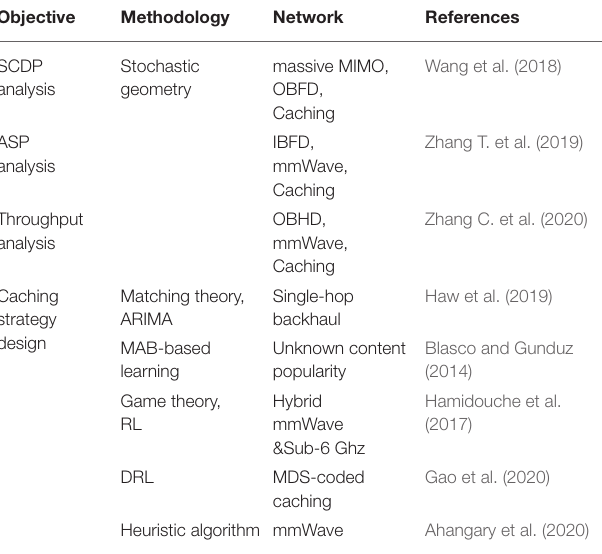
TABLE 4 | Taxonomy of literature in section